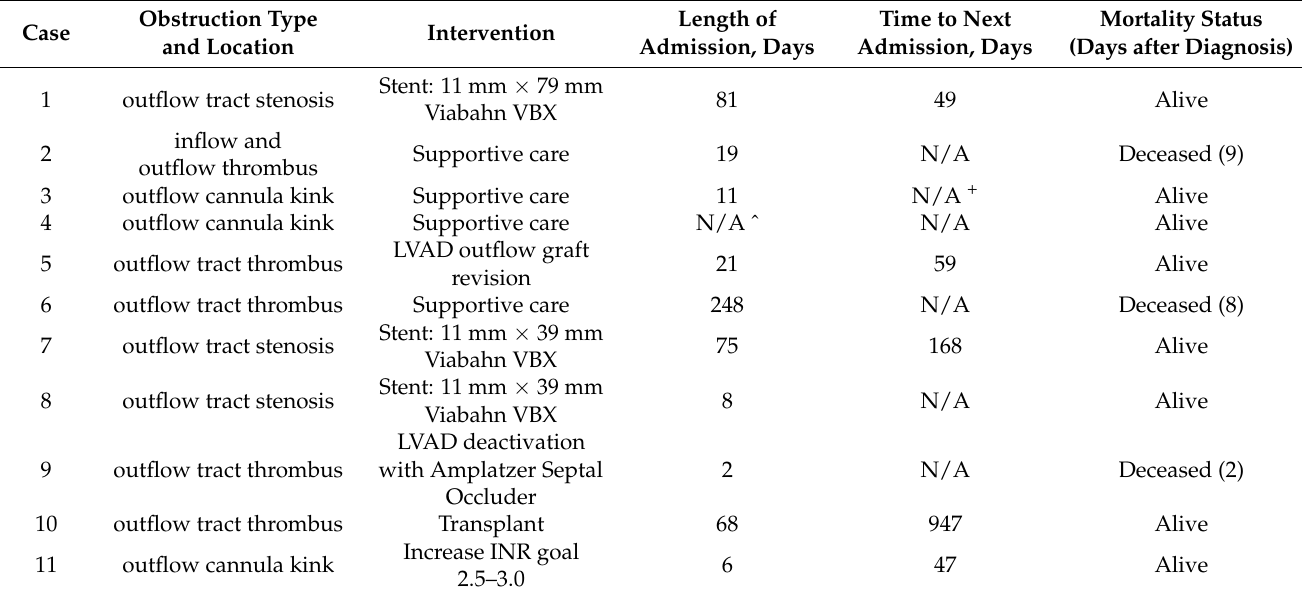
Table 4. Intervention and